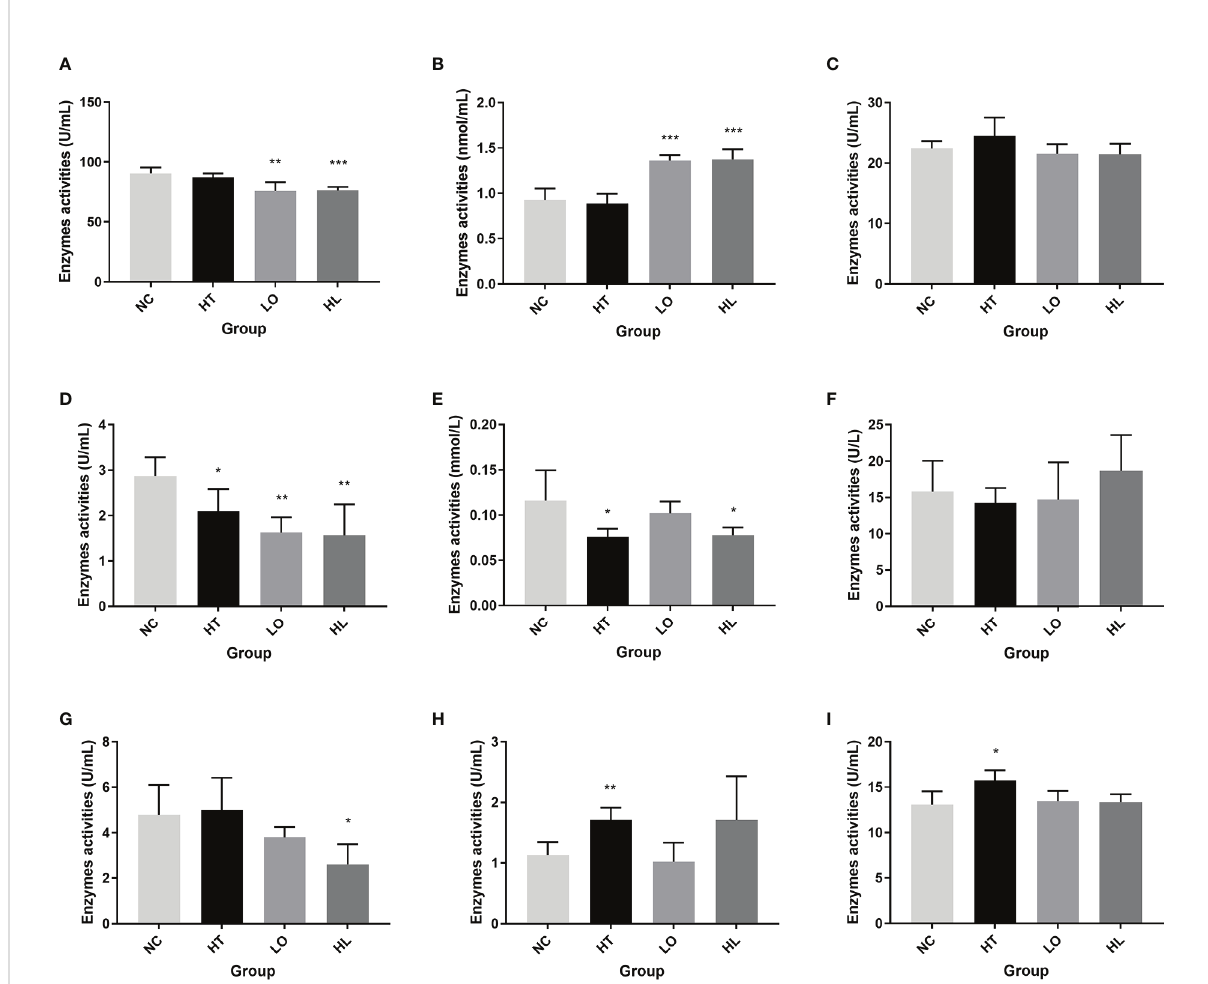
FIGURE 2 Activities of antioxidative enzymes in A. japonicus under environmental stresses (A) . superoxide dismutase (SOD); (B) malondialdehyde (MDA); (C) glutathione peroxidase (GSH-PX); (D) catalase (CAT); (E) total antioxidant capacity (T-AOC); (F) lactate dehydrogenase (LDH); (G) succinate dehydrogenase (SDH); (H) peroxidase (POD); and (I) phenol oxidase (PPO); *: P < 0.05; **: P < 0.01; ***: P <